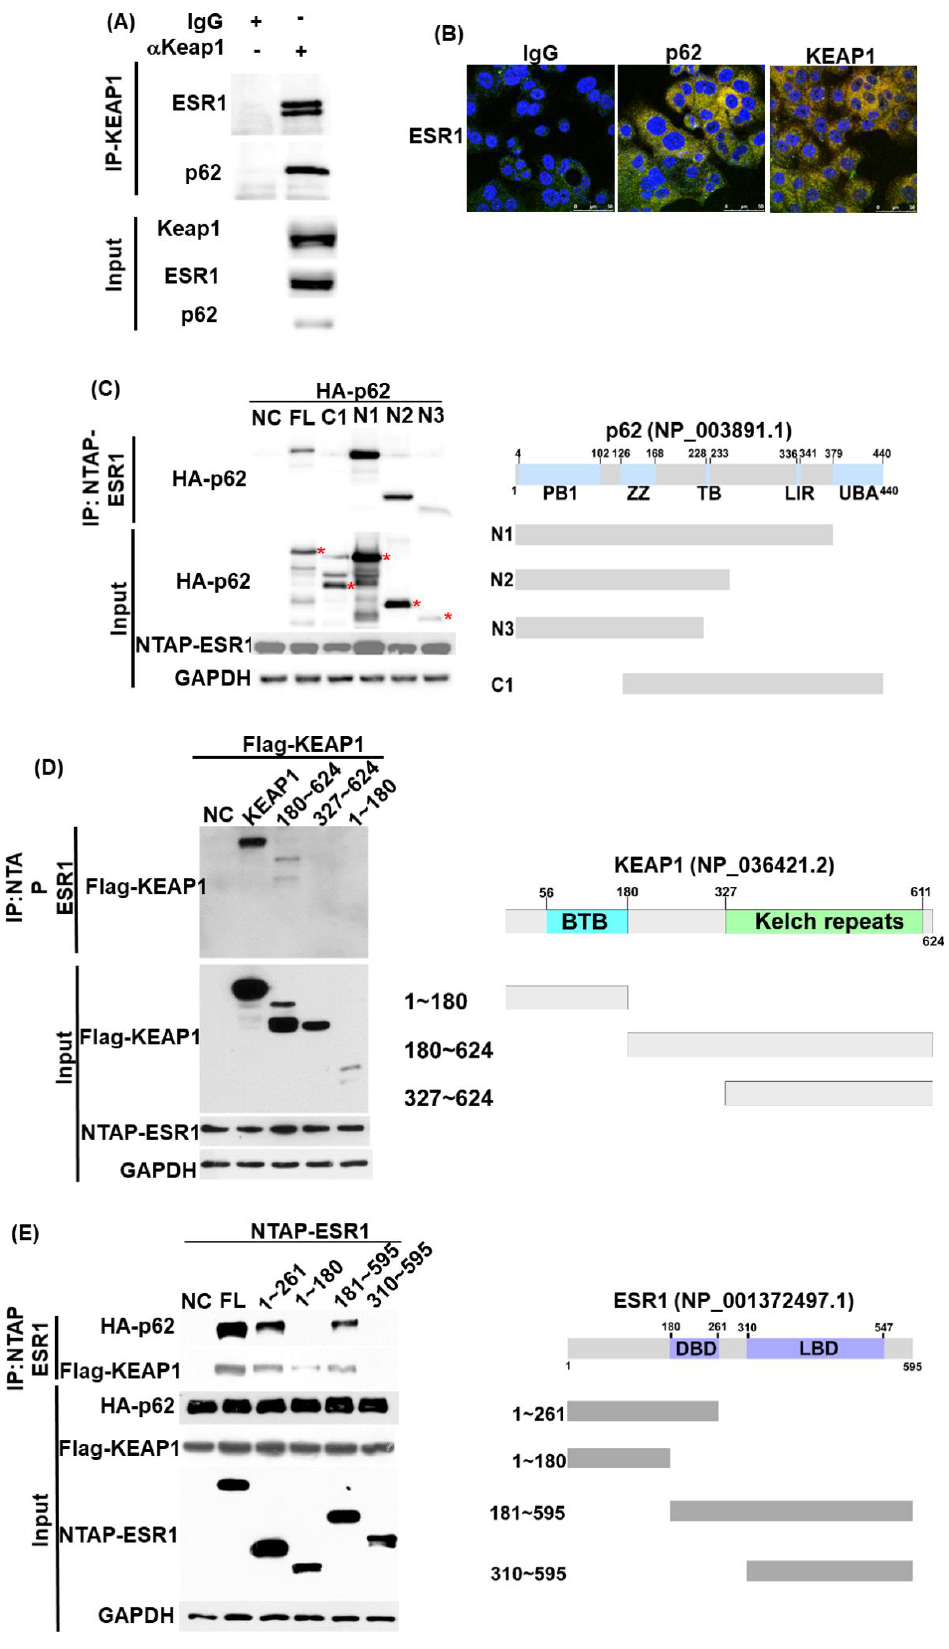
Figure 1. Estrogen receptor α ( ESR1), p62, and KEAP1 are capable of forming a complex. ( A ) Using Ishikawa cell lysates, the endogenous complex containing KEAP1 was pulled down with an anti-KEAP1 antibody and a control IgG. Associated